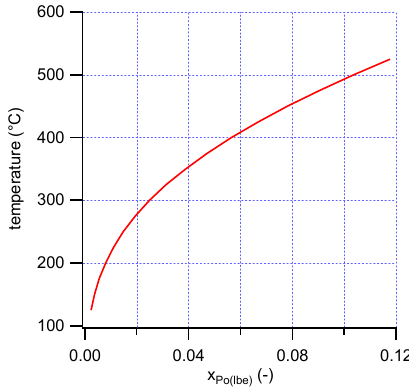
Figure 4. Estimated solubility (mol fraction) of PbPo(s) in liquid LBE. Because the solubility was derived from the dilute limit activity coefficient, the calculation was limited to ~1% Po in LBE.